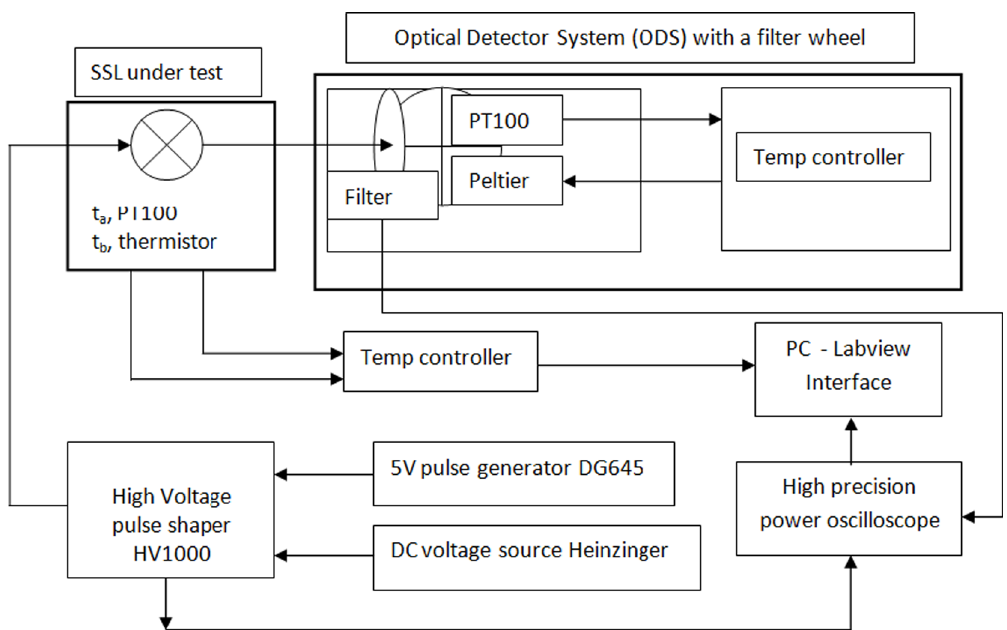
Fig. 2. Schematic of the traceable test setup developed at VSL. Table 2. Characteristics of the triggering and driving equipment.